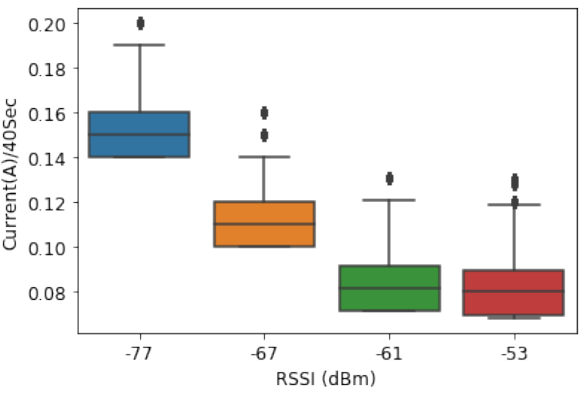
Figure 13. Current consumption vs. RSSI in 40-second time